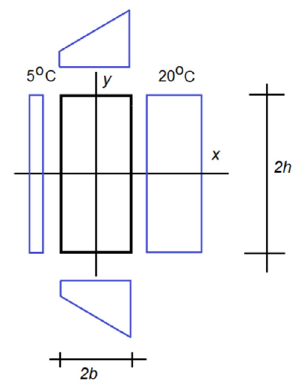
Figure 3. Example of boundary conditions of temperature in the shield.